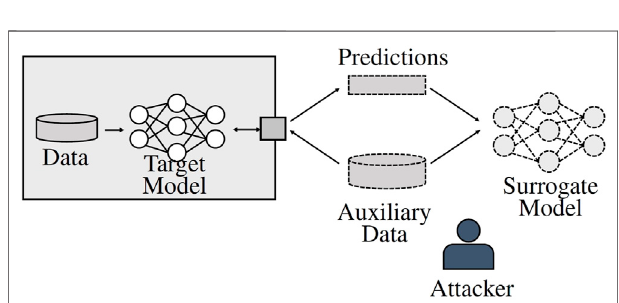
FIGURE 3 | Process of a model extraction attack. The attacker holds auxiliary data from a similar distribution as the target model ’ s training data. Through query access, the attacker obtains corresponding labels for the auxiliary data. Based on that data and the labels, a surrogate model can be trained that exhibits a similar functionality to the original